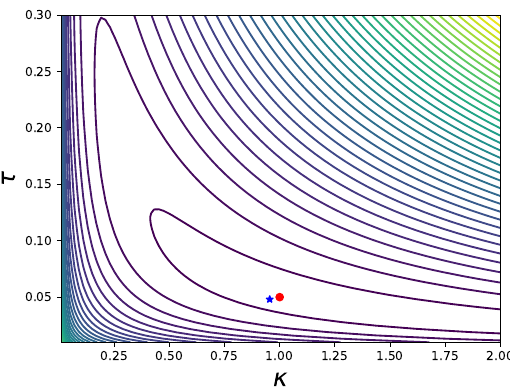
Figure 4 Level sets for value function v ( θ ) (9) for the quantile Huber model. The black star is the maximum likelihood estimator, while the red dot represents the true parameters in the